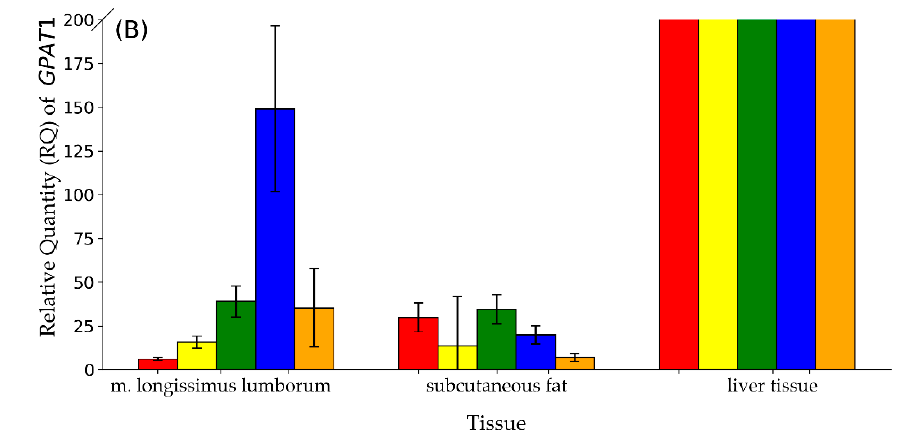
Figure 3. Relative quantity (RQ) of GPAT1 transcript abundance between all individuals within breeds in analyzed tissues: m. longissimus lumborum subcutaneous fat, liver tissue (** p ≤ 0.01). Data are presented as means ±SEM. ( A ) Full chart; ( B ) zoomed in chart with y-axis ranging from 0 to 200.